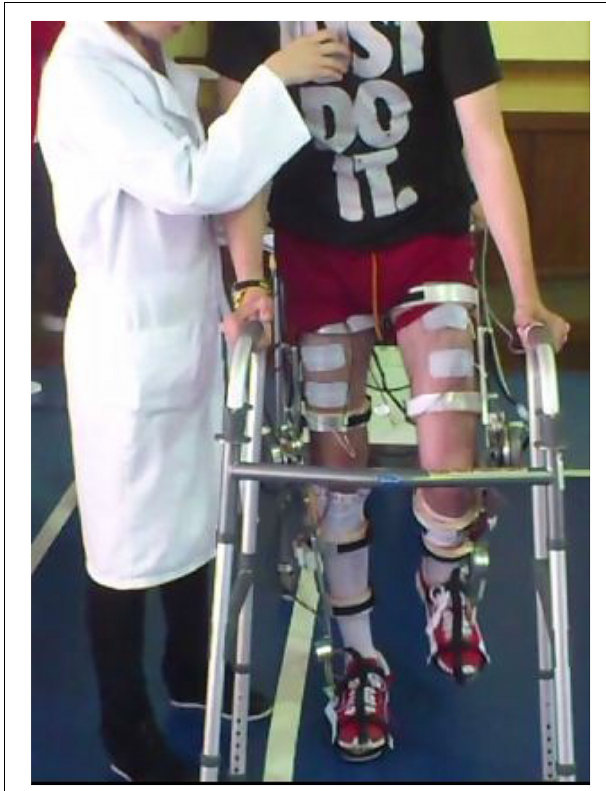
FIGURE 2 | Experimental setup for data collection and testing hybrid gait training with Kinesis overground robot.